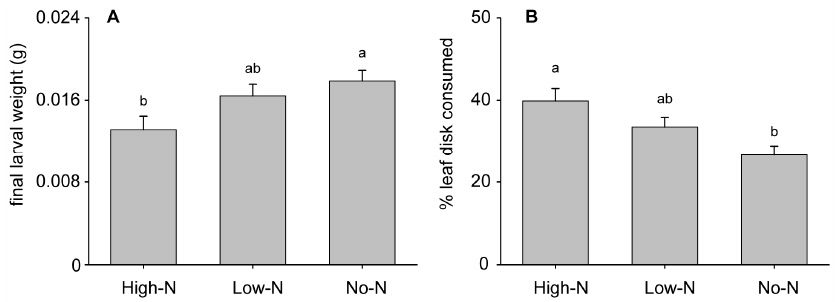
Figure 2. Effects of dependence on rhizobial N by 5-week old soybeans on ( A ) growth of H. zea larvae in a no-choice assay (starting as neonates), and ( B ) larval feeding preference in a 3-way choice test (third instar larvae). High-N = High N fertilizer treatment, Low-N = Low N fertilizer treatment, and No-N = no fertilizer. Different lowercase letters indicate significant differences. Results shown as means ± S.E ( n =